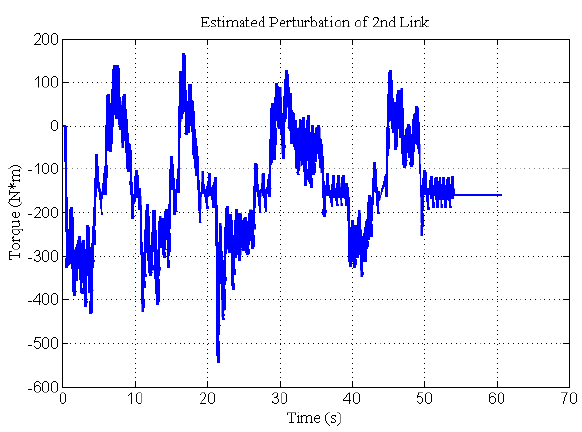
Figure 17. Estimated perturbation of the master’s 2 nd link.